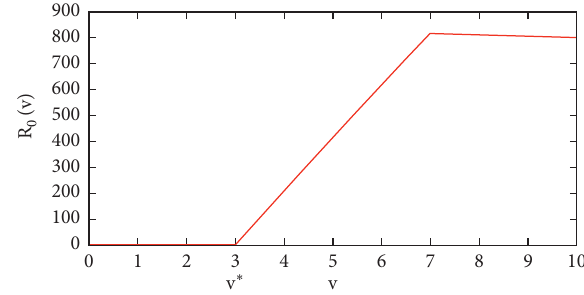
Figure 2: Variation of R